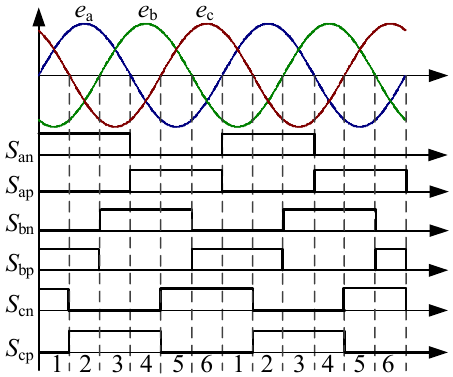
Figure 6. The control method of the virtual director switches S k p and S k n.